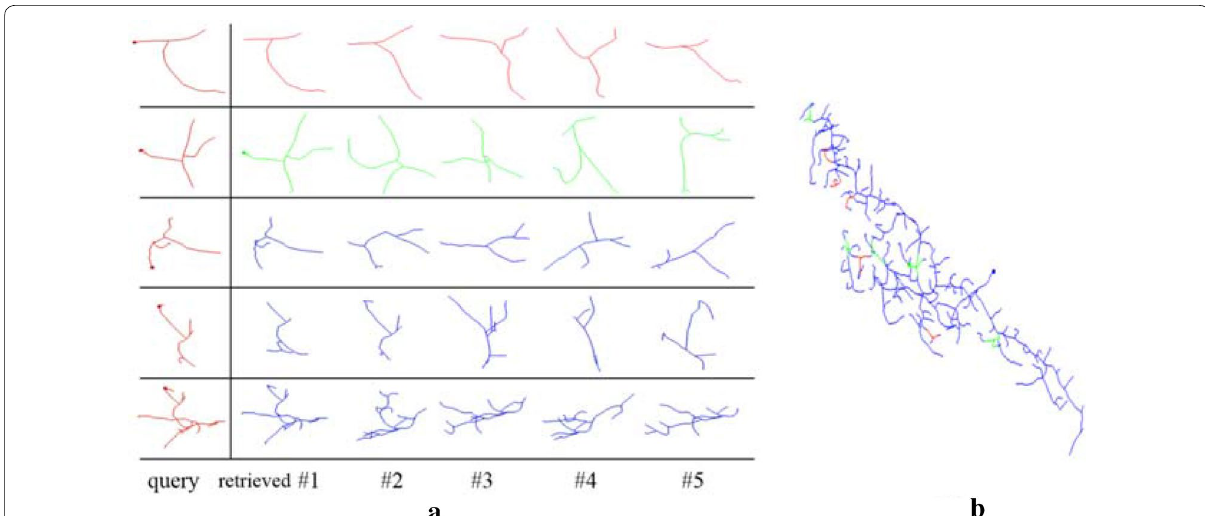
Fig. 4 Retrieved substructures on a fruit fly neuron. a Each row gives a query substructure and its five most similar substructures on the neuron retrieved by MS. b Substructures in the first two rows of a are demonstrated on the neuron (substructures of the first row are in red and the second are in green)